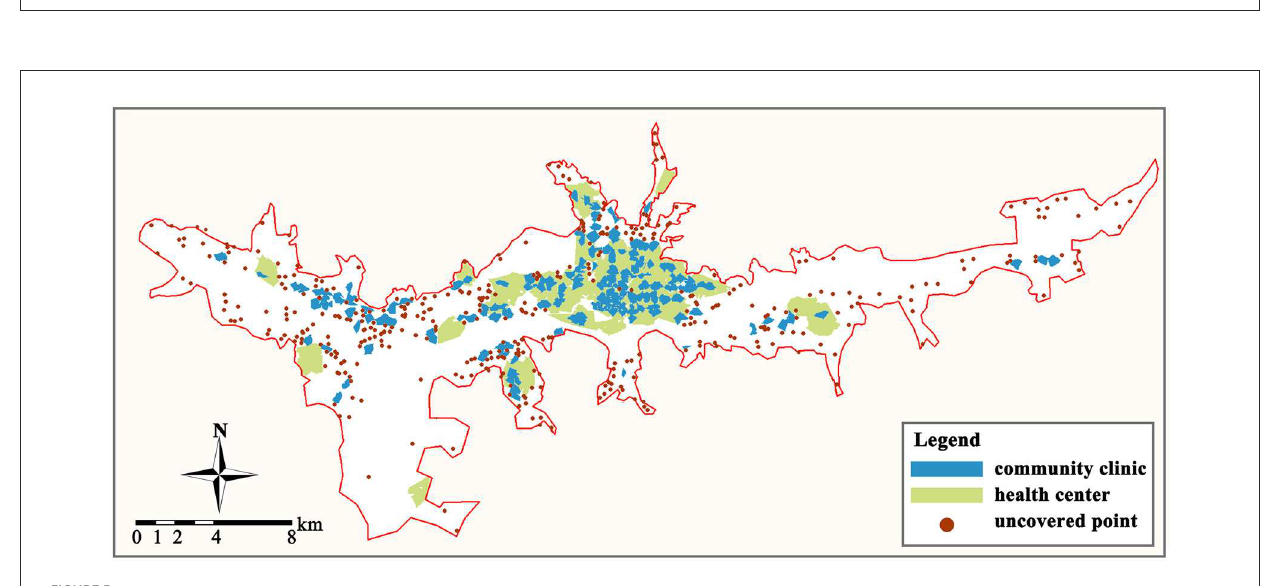
FIGURE5 Service area of primary care facilities and uncovered